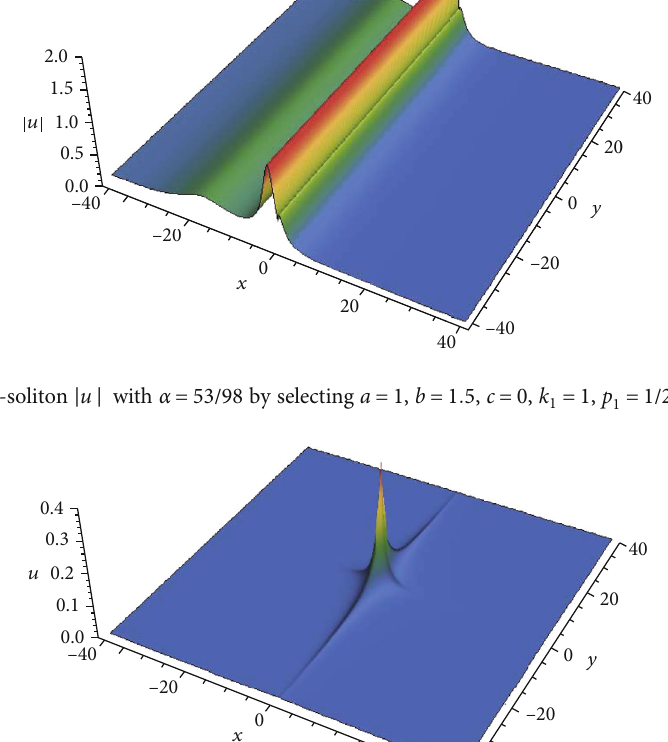
= 1 , p = 1/2 , σ = 1 , ξ ð 0 Þ = 0 , 1 1 1